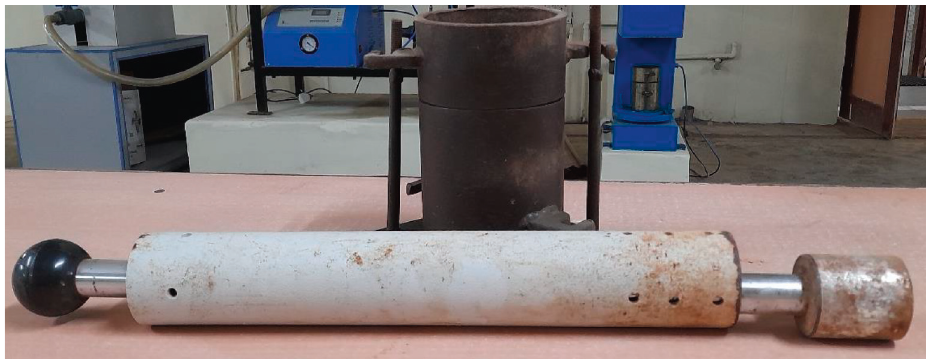
Figure 3: Set up for performing standard compaction tests.